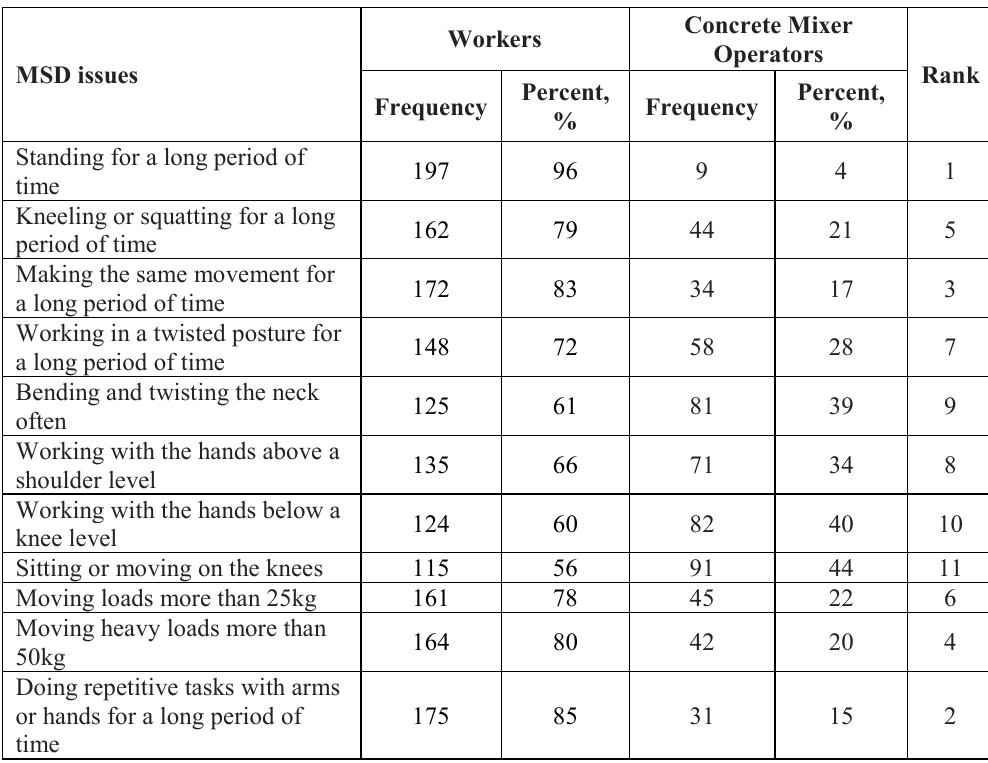
Table 2. Activities Contributing to Musculoskeletal